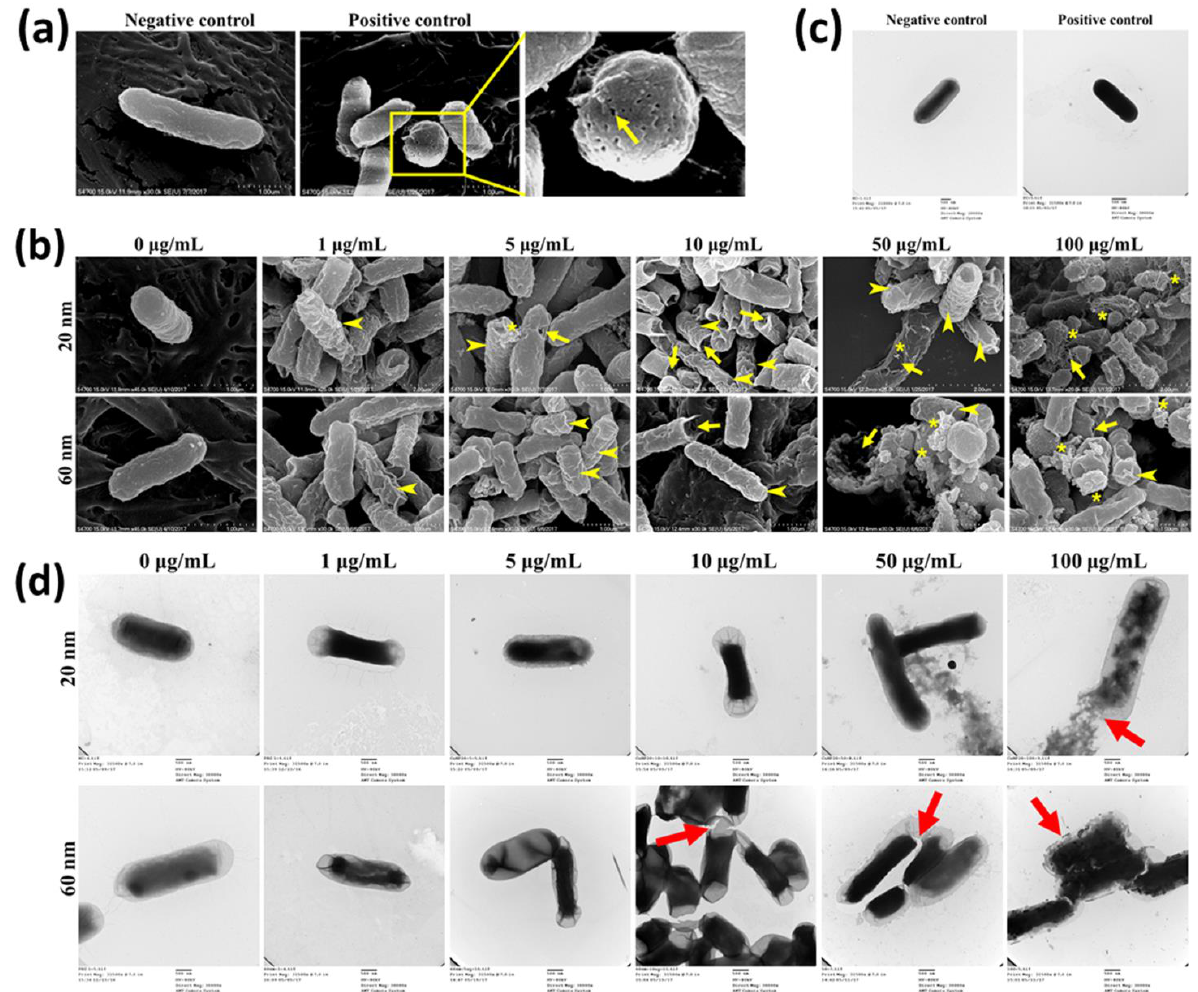
Figure 2. Electron microscopy images of E. coli treated with two sizes of CuNPs in different concen- trations. Cells treated with PBS or 70% alcohol served as the negative control and positive control, respectively. ( a , b ) Live or dead cells observed via SEM. Images were obtained using a S-4700 SEM with a magnification of 30,000×. Arrow heads indicate the wrinkles of cell membranes; arrows mark the cracks on plasma membranes; stars illustrate the cytoplasmic components leaking from cells. Scale bar = 1 μm ( c , d ) Live or dead cells observed via TEM. Images were obtained using an H-7500 TEM with a magnification of 30,000 × . Two percent of uranyl acetate was applied for the negative stain of cells followed by TEM imaging. Arrows indicate the membrane damage. Scale bar = 500